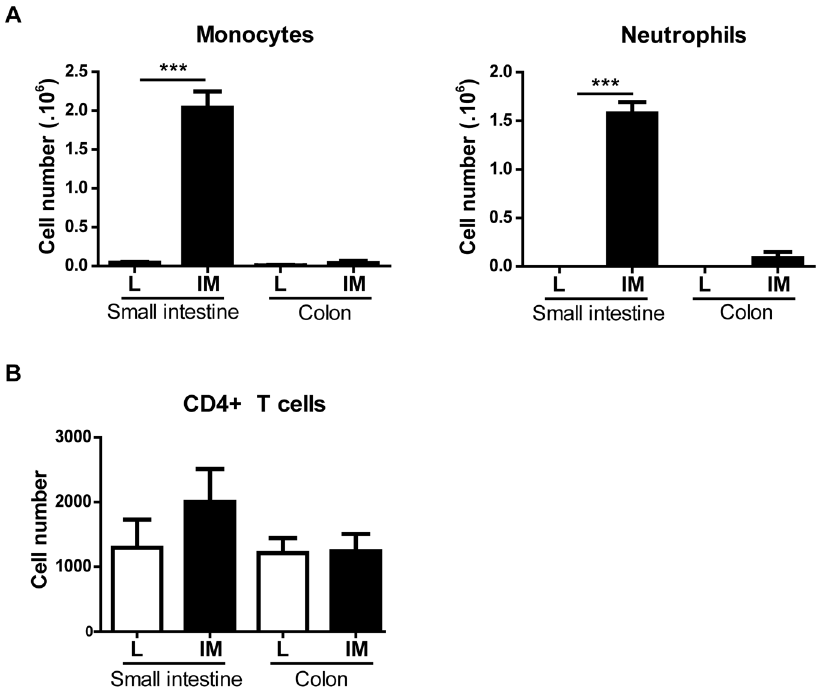
Figure 7. Monocytes and neutrophils are the 2 populations infiltrating the intestinal muscularis after Intestinal Manipulation. (A) Both monocytes (CD11b + Ly6G–) and neutrophils (CD11b + Ly6G + ) numbers are increased in the small intestine muscularis but not the colonic muscularis 24 h after Intestinal Manipulation. (B) No influx of CD4 + T cells is observed in the muscularis of the small intestine or the colon 24 h after Intestinal Manipulation. All populations were gated from CD45 + population. Data shown are mean 6 SEM of 4–5 animals per group. ***p , 0.001 (Student t-test).